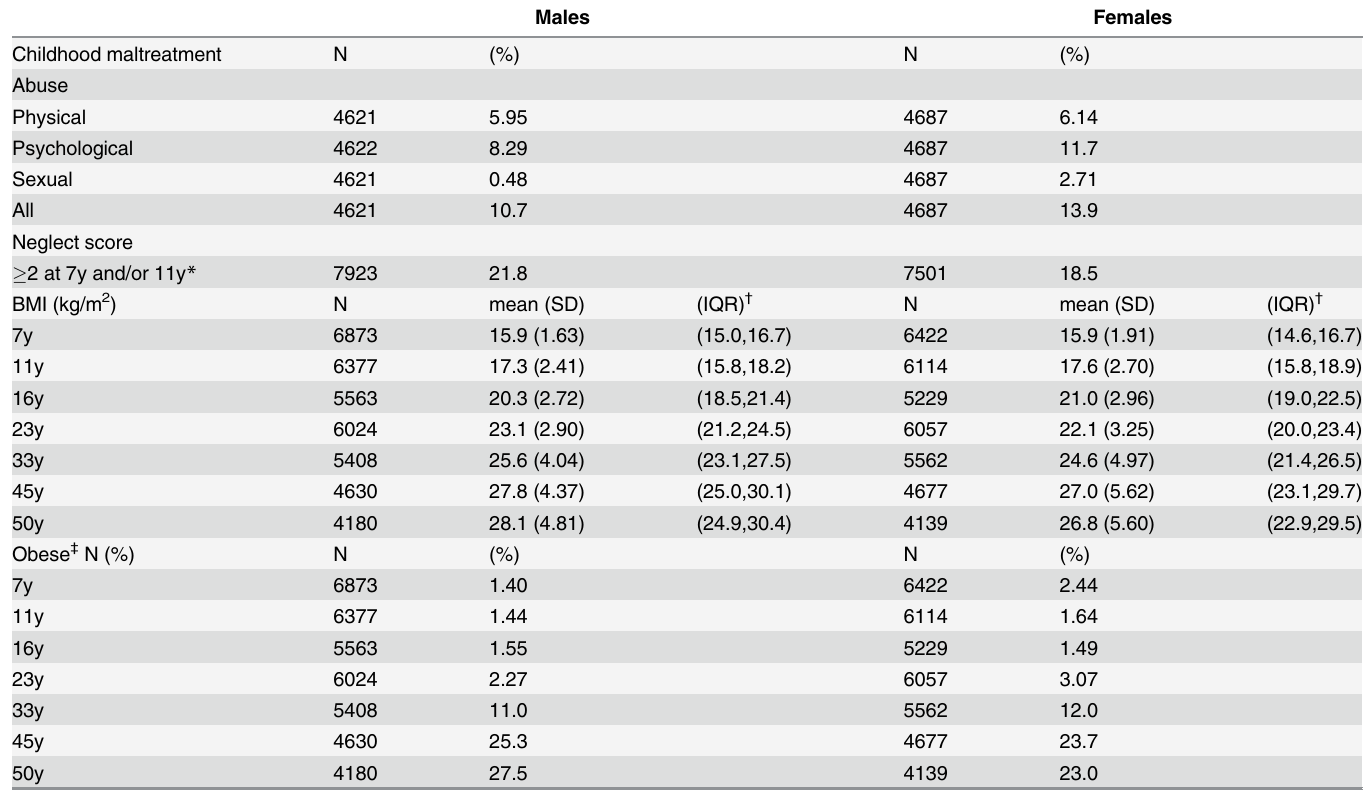
Table 1. Characteristics of the 1958 British birth cohort study.